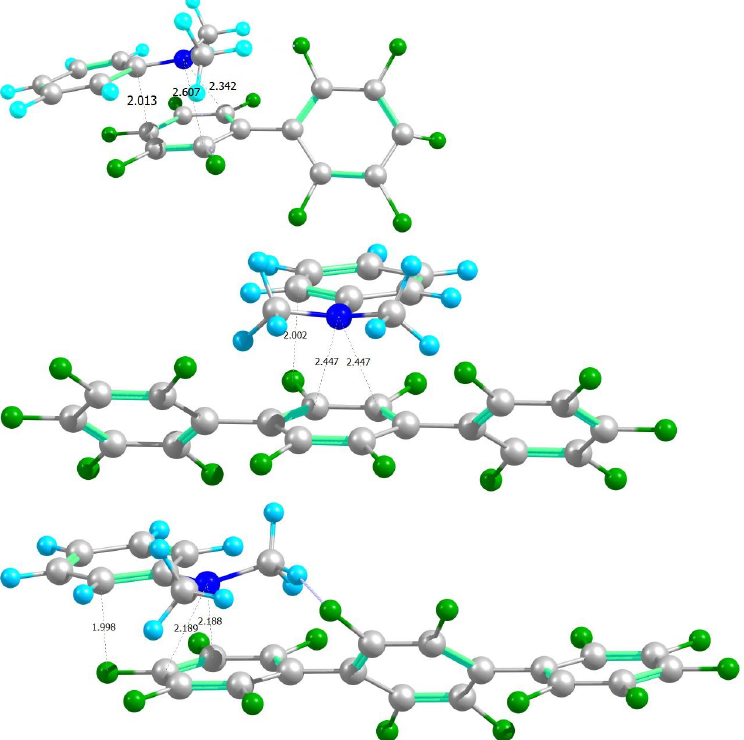
Figure 7. Top to bottom: structures of exciplexes formed by DMA over the outer ring of 1 *, inner ring of 2 * and outer ring of 2 *. The colors of the atoms are as follows: H—cyan, C—gray, N—blue,